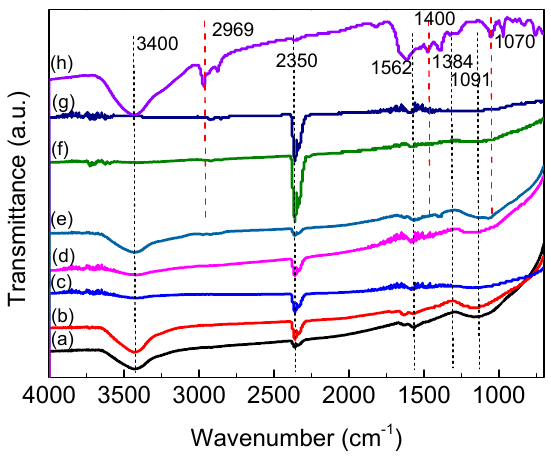
Figure 2. Fourier transform infrared spectra (FT-IR) spectra of ( a ) AC, ( b ) AC-HNO 3 , ( c ) AC-HCl, ( d ) Ru/AC, ( e ) TPAP/AC, ( f ) TPAP/AC-HNO 3 , ( g ) TPAP/AC-HCl, ( h ) TPAP. The characteristic peaks are centered at: 1091 cm − 1 : C–OH; 1384 cm − 1 : C=O; 1562 cm − 1 : COOH; 2350 cm − 1 : C ≡ N; 3400 cm − 1 : phenolic hydroxyl; 1070 cm − 1 : C–N; 1400 cm − 1 : –CH 3 ; 2969 cm − 1 : –C–H.